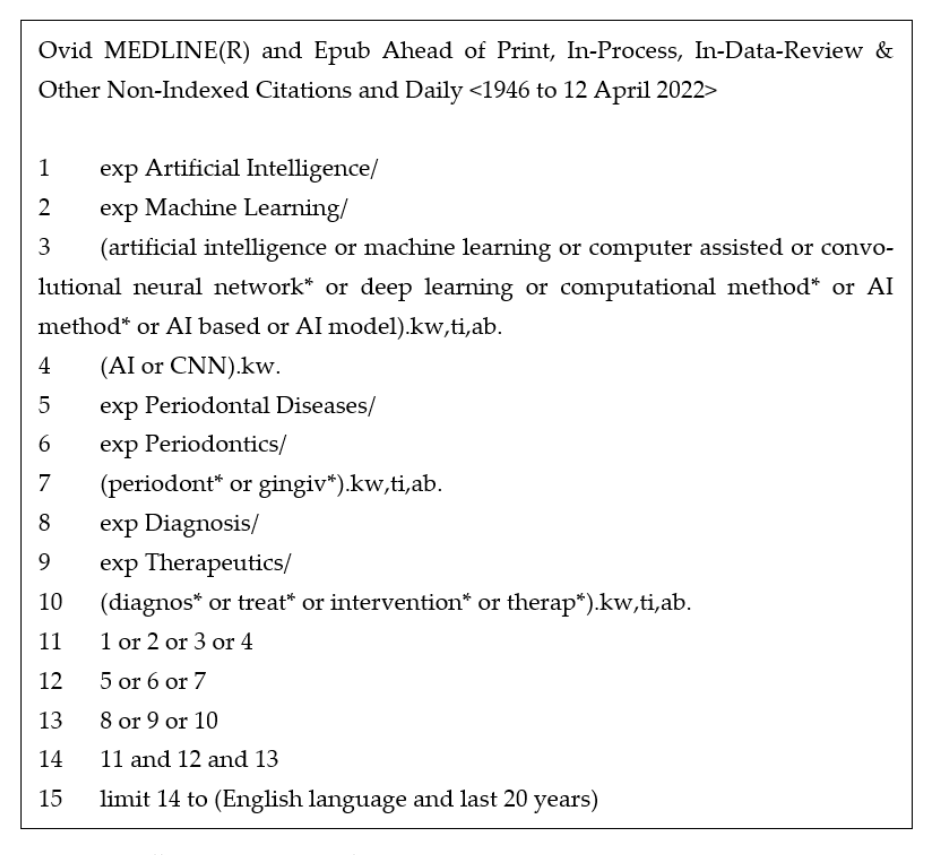
Figure 1. Medline via OVID search strategy.